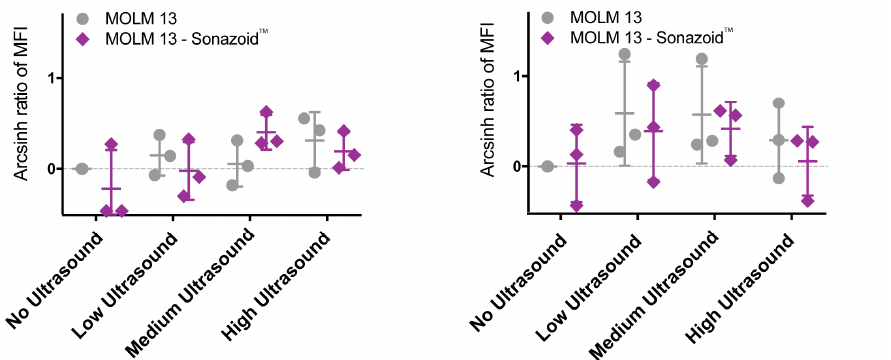
Figure 7. Changes in phosphorylation as observed for ribosomal protein S6 in MOLM-13